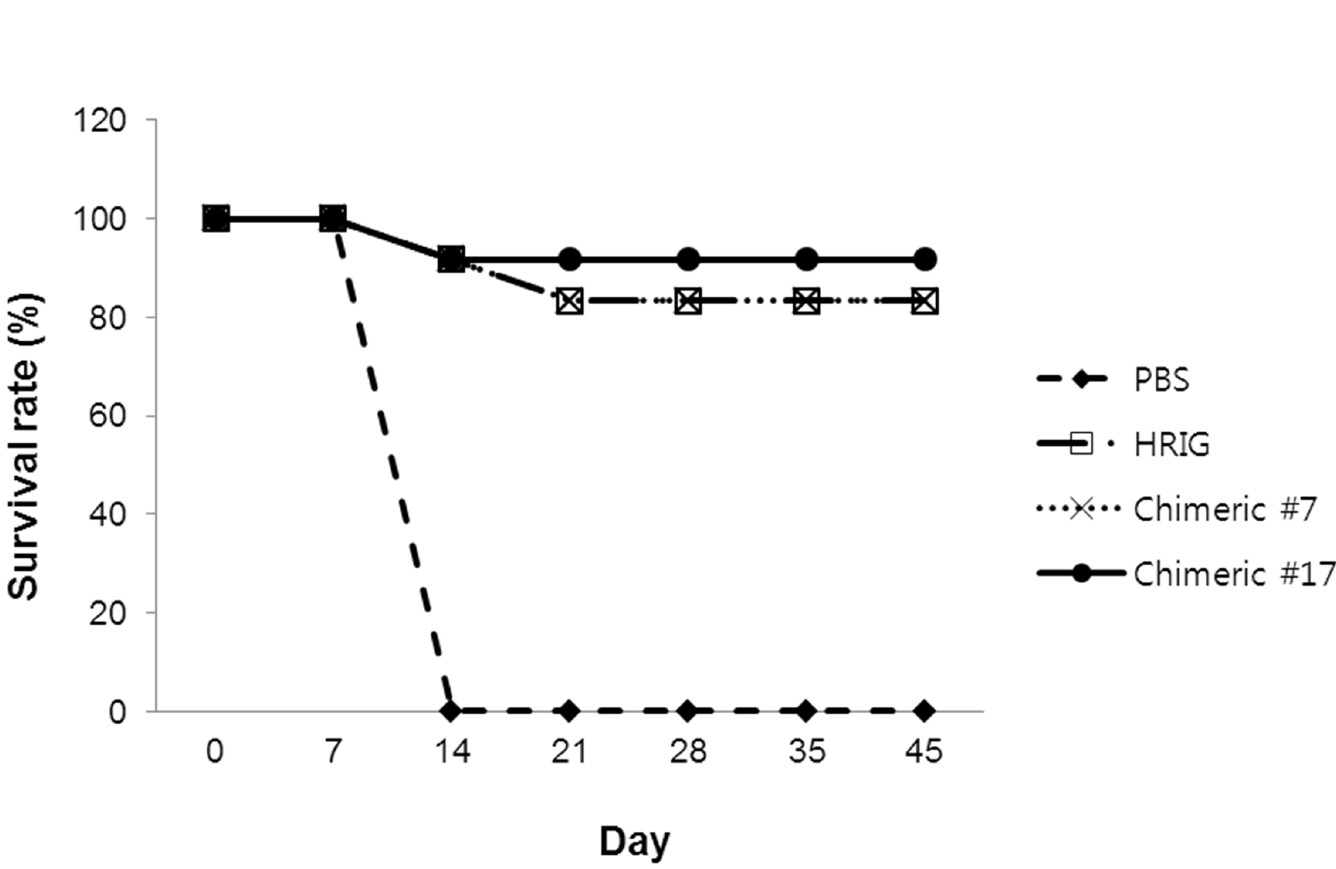
Fig 4. Established MAbs protect hamsters against lethal RABV infection. Syrian hamsters were dividedinto four groups (n = 12 in each group) and a MICLD 50 of RABV RV342from Chinawas injected1 day before antibodytreatment. HRIG and chimeric MAbs #7 and #17 were administered, and animals were monitoreddaily.